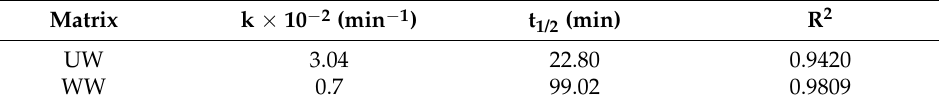
Table 1. Kinetic parameters (rate constants, correlation coefficients (R 2 ), half-lives (t 1/2 )) of amisul- pride photocatalytic degradation in UW and WW.